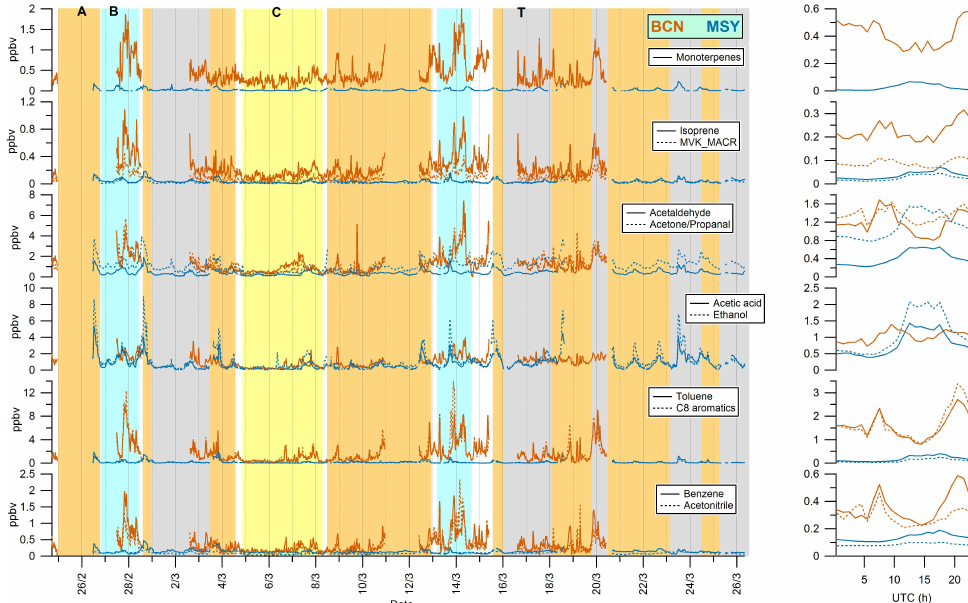
Fig. 3. Left panels: Time series of volatile organic compound mixing ratios measured at BCN (vermillion traces) and MSY (blue traces). Background colors correspond to the atmospheric scenarios described in Sect. 2.4: A (orange), B (light blue), C (yellow) and T (grey). Date labels indicate 00:00UTC. Right panels: Hourly averaged diurnal cycles of the entire time